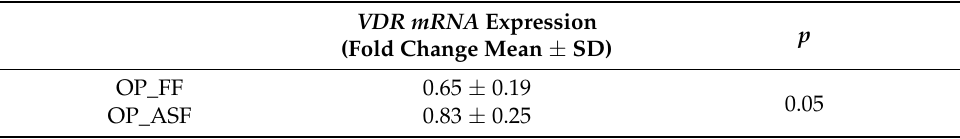
Table 3. Association between VDR mRNA expression levels and the fracture bone site of the OP